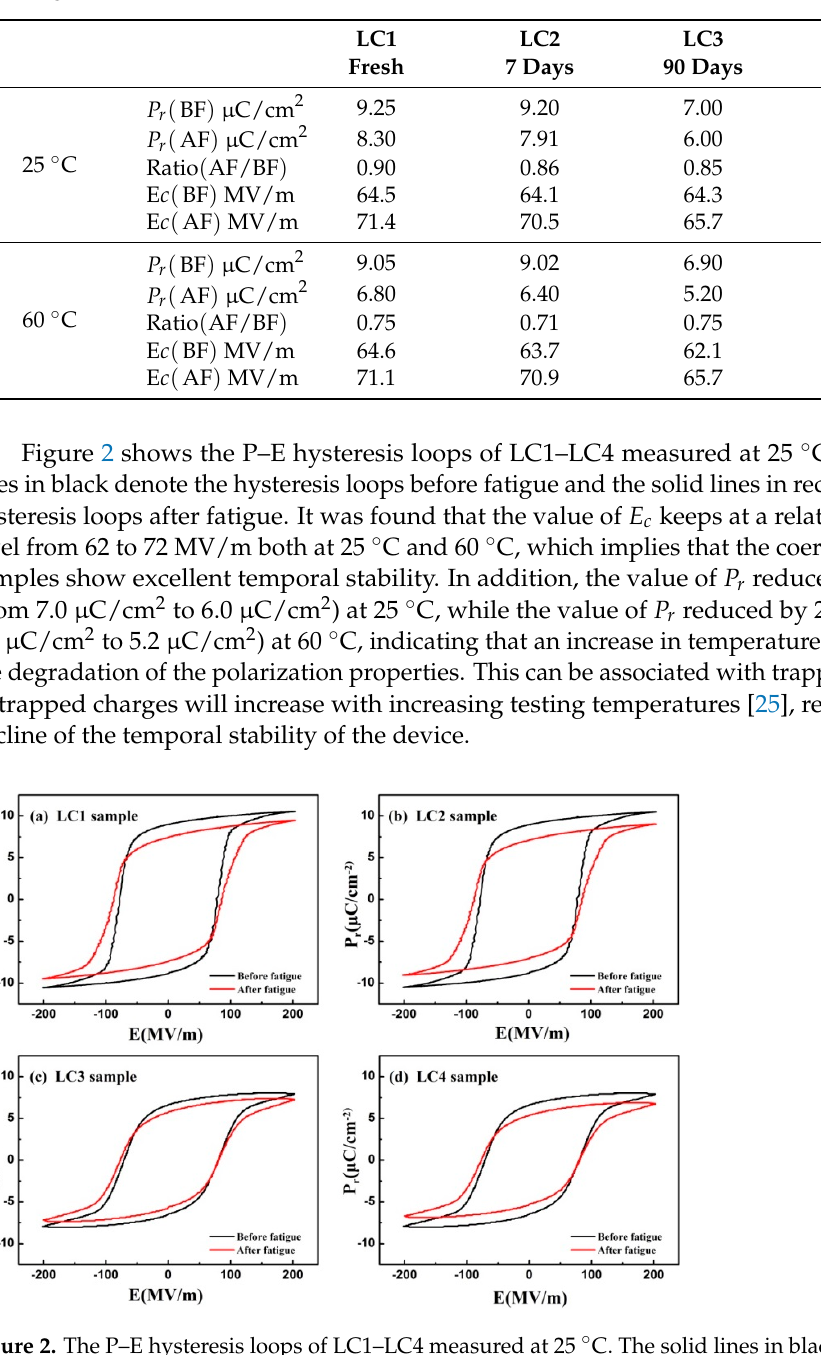
Table 1. The remnant polarization ( P r ) and coercive field ( E c ) for the LC1–LC4 samples before and after fatigue at 25 ◦ C and 60 ◦ C.